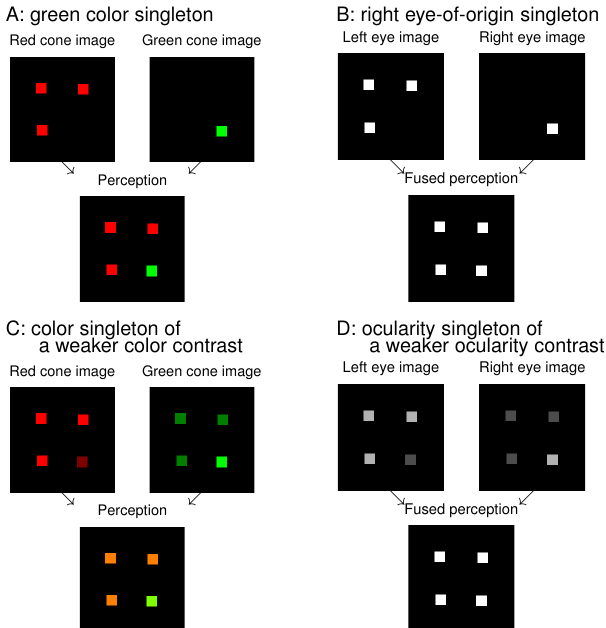
Figure 1. Analogies and differences between colour singletons ( A , C ) and ocularity singletons ( B , D ). In each of (A–D), two input components are shown at the top and the resulting perception at the bottom; the singleton is the lower right dot in the bottom image. When the inputs to the left eye and right eye are viewed as analogous to inputs to the red cones and green cones, respectively, (B) and (D) are analogous to (A) and (C), respectively. The colour distinctions of the singletons in (A,C) are highly visible perceptually, and the ocularity distinctions of the singletons in (B,D) are not. However, all four singletons can attract attention